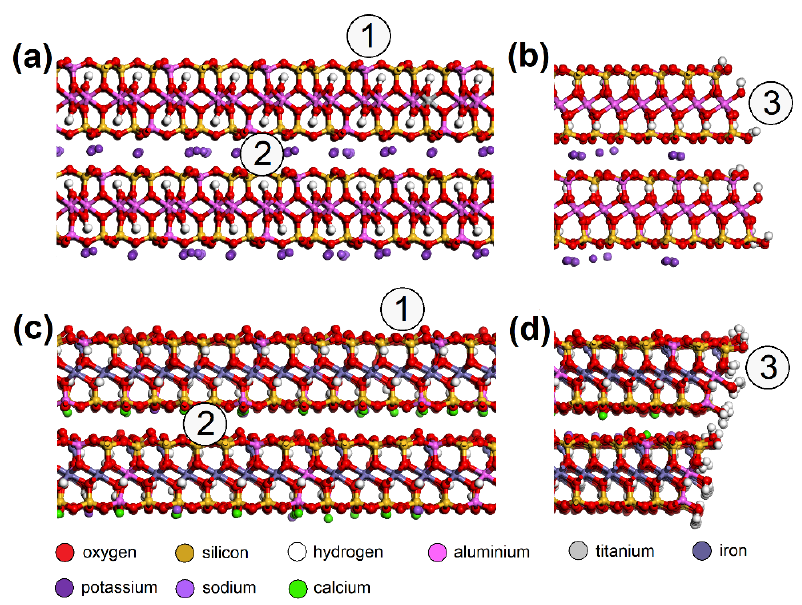
Figure 5. Molecular models of MUS ( a ) surface, ( b ) edge; and NON ( c ) surface and ( d ) edge — with spots where the NO or SO 2 molecule was placed: (1) surface, (2) interlayer, (3) edge. MUS—muscovite, NON — nontronite.